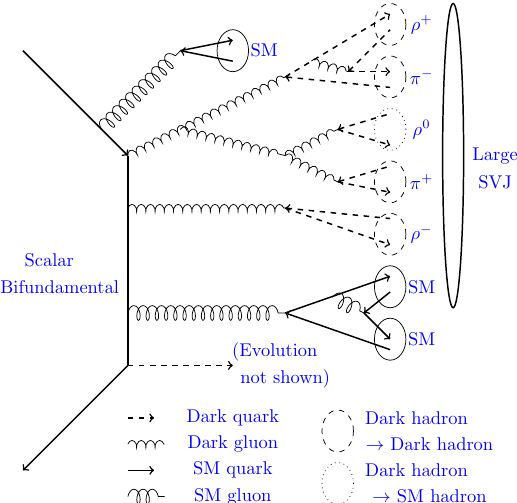
Figure 2: A schematic illustration of how semi-visible jets are produced in t-channel. Inspired by [ 7 ]